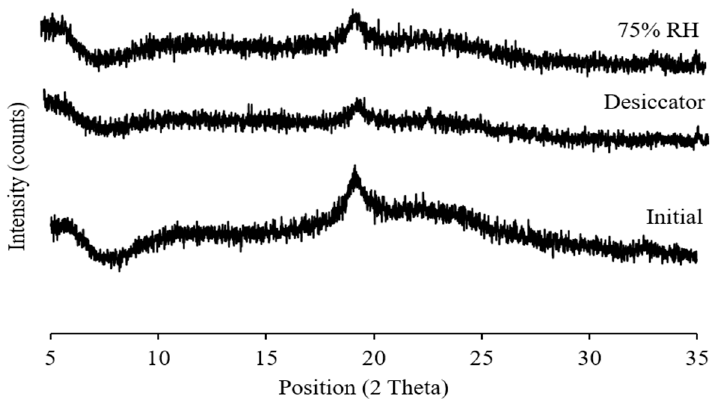
Figure 7. X-ray diffractograms of spray-dried bedaquiline with 20% w/w of L -leucine powder after one month’s storage at 30 ± 2% RH and ambient room temperature (in desiccator) and at 75 ± 2% RH and 25 ± 2 °C (elevated condition) (initial data from Figure 2 was used for comparison).